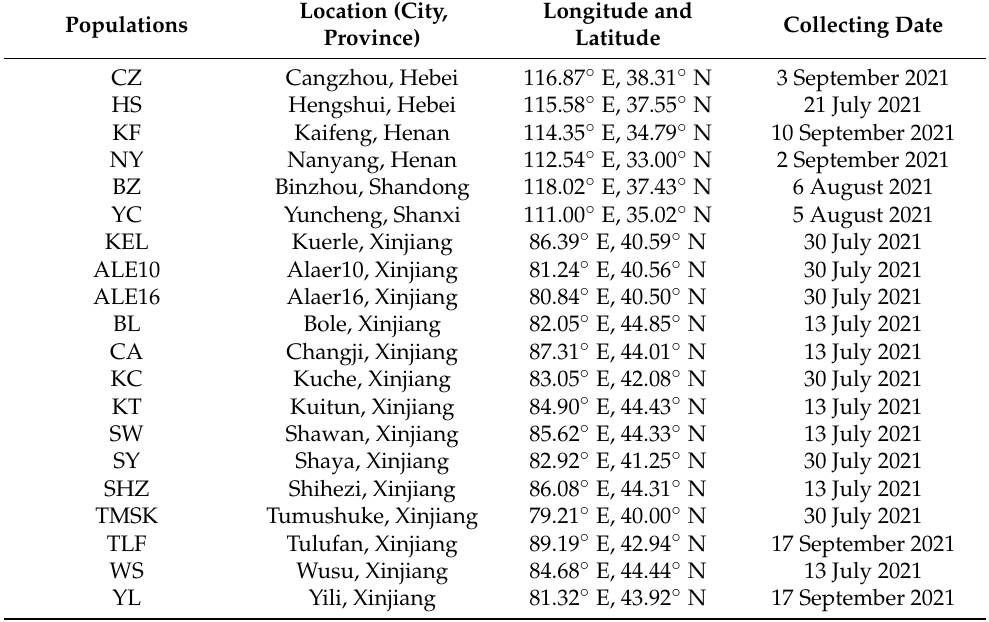
Table 1. Information of Aphis gossypii field populations used for bioassay in China. Location (City, Populations